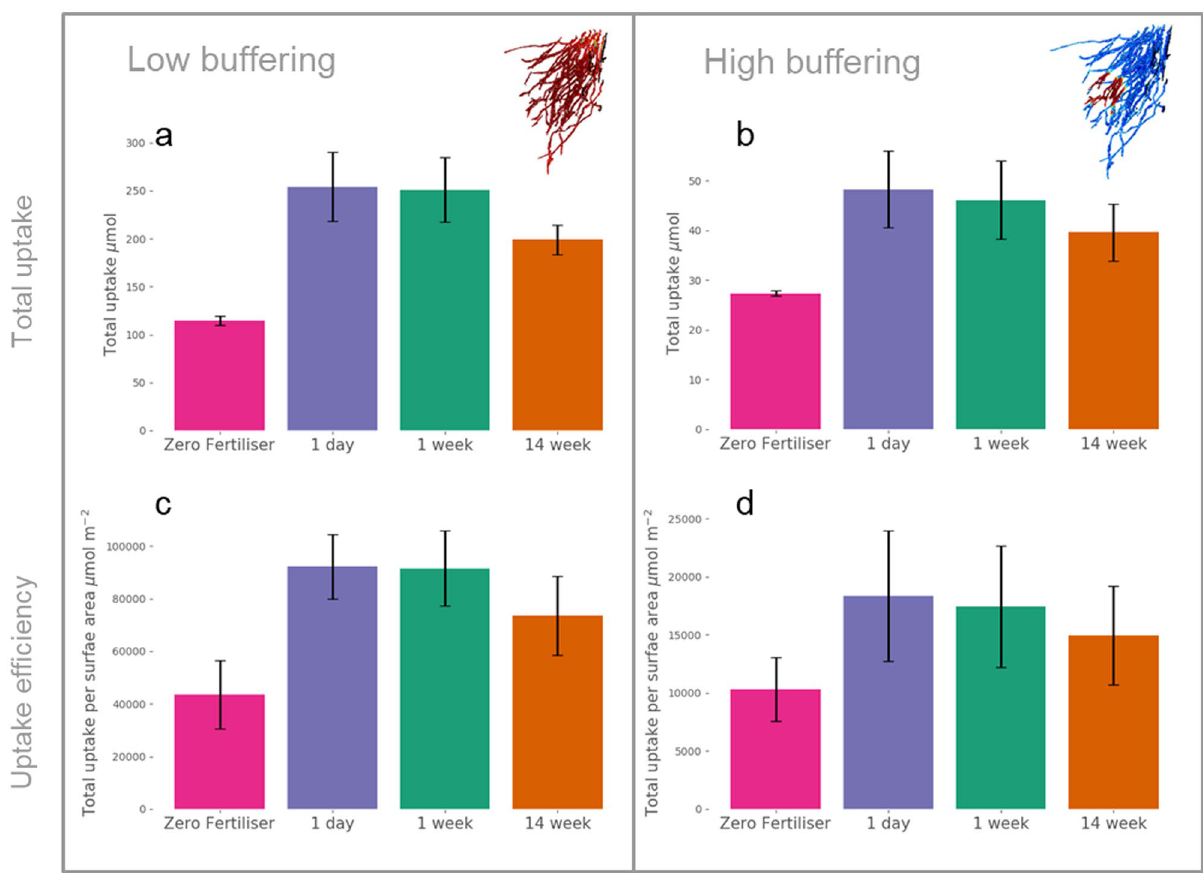
Figure 4. Simulated total phosphorus uptakes integrated over the whole experiment for different P dissolution rates averaged across 3 root systems ( a , b ) and total uptakes per root surface area ( c , d ) over the fertiliser treatments. Error bars show standard deviation, n = 3. ( a ) Total uptake averages in the low buffering soil. ( b ) Total uptake averages in the high buffering soil. ( c ) Total uptake per root surface area averages in the low buffering soil. ( d ) Total uptake per root surface area averages in the high buffering soil. For visualisation purposes, root images show uptake rate at 43